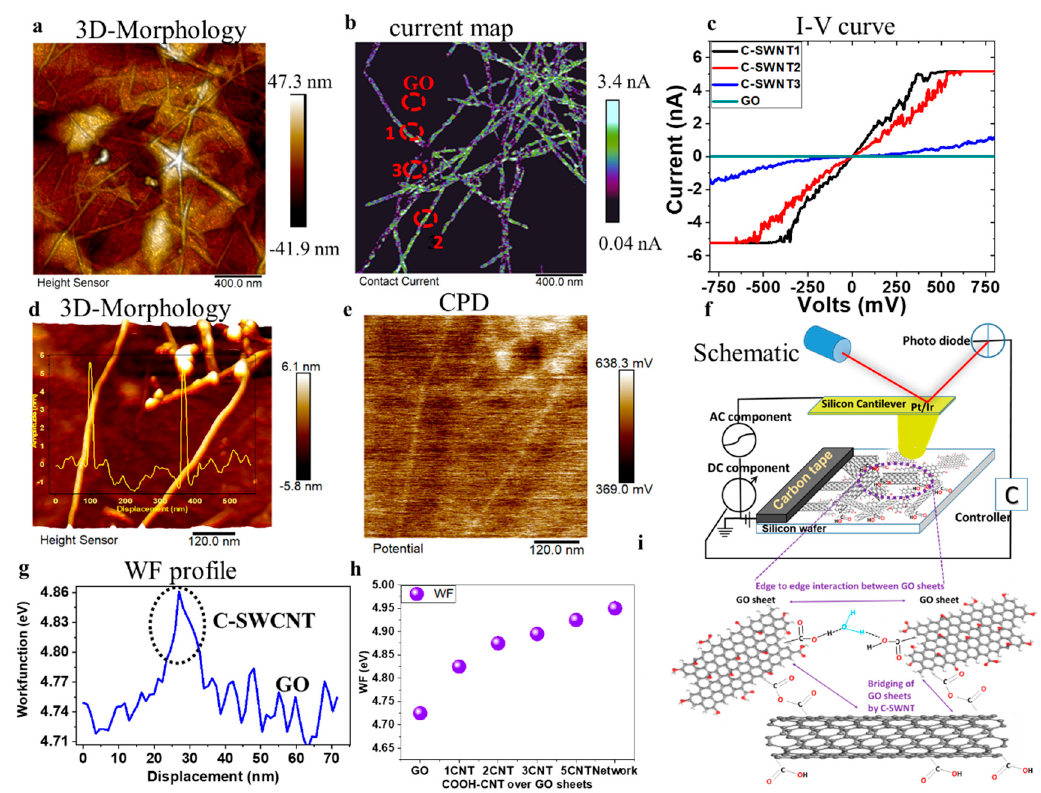
Figure 4. ( a ) 3D-AFM topography of C-SWNTs on GO surface, showing their distribution and networking with each other over GO sheets. ( b ) The local conductivity map contrast between C-SWNT and GO sheets under a bias voltage of 900mV. ( c ) I-V curve carried out at 3 di ff erent C-SWNTs marked as 1, 2 and 3 showing the impact of functional groups on local electrical property. ( d ) 3-D morphology carried under KPFM operation in first-pass scanning shows individual C-SWNTs of a diameter nearly 5nm connected to its network. ( e ) The CPD (mV) contrast (second pass) between individual C-SWNT illustrating the di ff erence in the work function (WF) between GO sheets, individual C-SWNT and its network. ( f ) Schematic view of the AFM set-up of the same sample used for C-AFM and KPFM measurements. ( g ) WF profile of an individual C-SWNT marked by dotted circle which is higher than in the surrounded GO. ( h ) The trend of increasing WF values with accumulation of C-SWNTs. ( i ) Enlarged representation of the proposed bridging mechanism of GO sheets by C-SWNT and the edge interaction between GO sheets through water molecules [46,57].